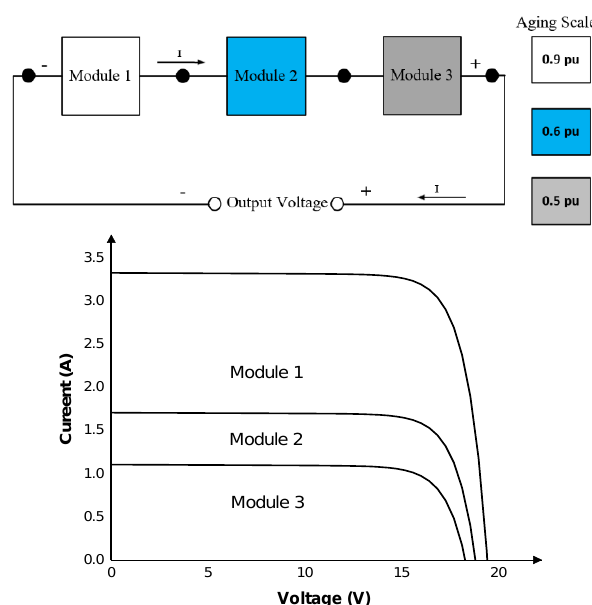
Figure 6. Series-connection of PV modules.